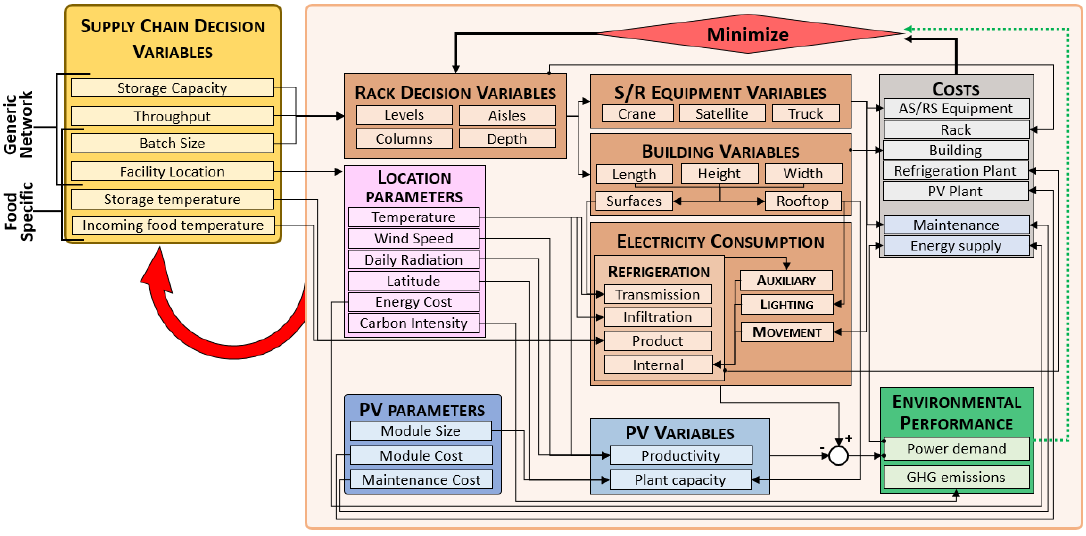
Figure 1. A framework for integrating cold chain, photovoltaics, and R-AS/RS design models.